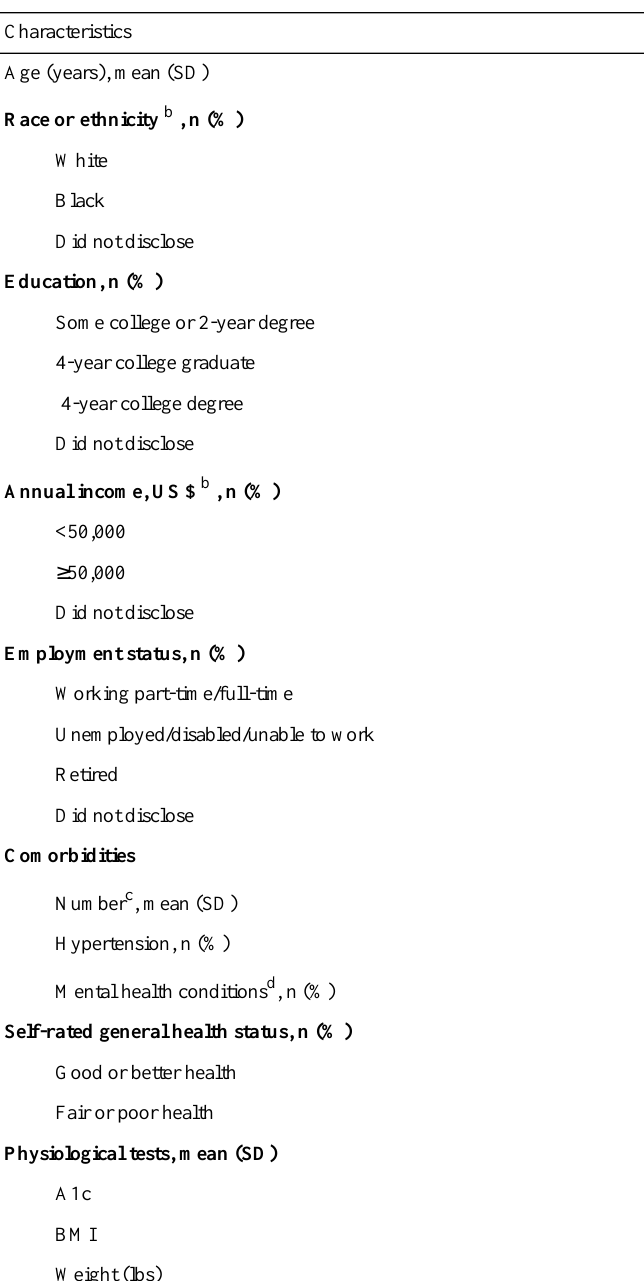
Table 1. Participant baseline a characteristics